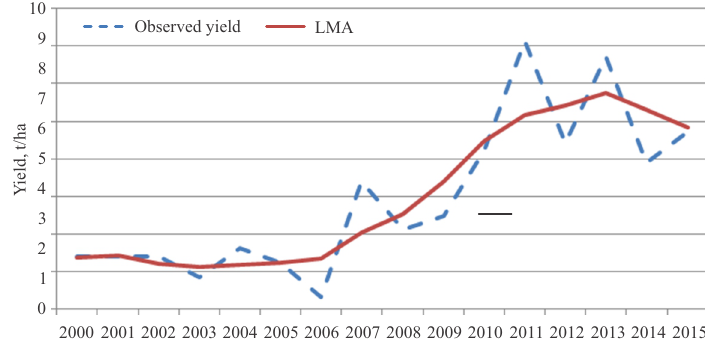
Fig. 1. Dynamics in mixed cereal yield in Vilnius